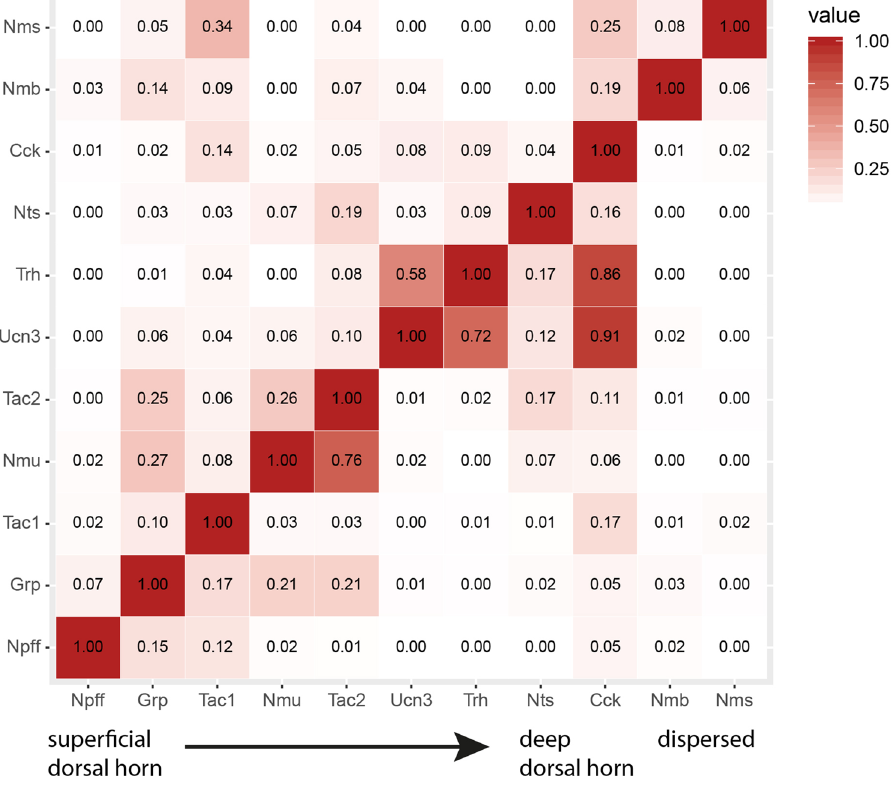
Figure 6. Co-expression matrix of eleven neuropeptides expressed in excitatory neurons. Co-expression within cells expressing a neuropeptide clearly above background levels (> 20 dots/cell). Depicted is the fraction of cells expressing the neuropeptide on the left, that also express the neuropeptide at the bottom. For example, 0% of the Nms cells, also express Npff. Color key indicates co-expression with light colors representing low co-expression and dark values representing high